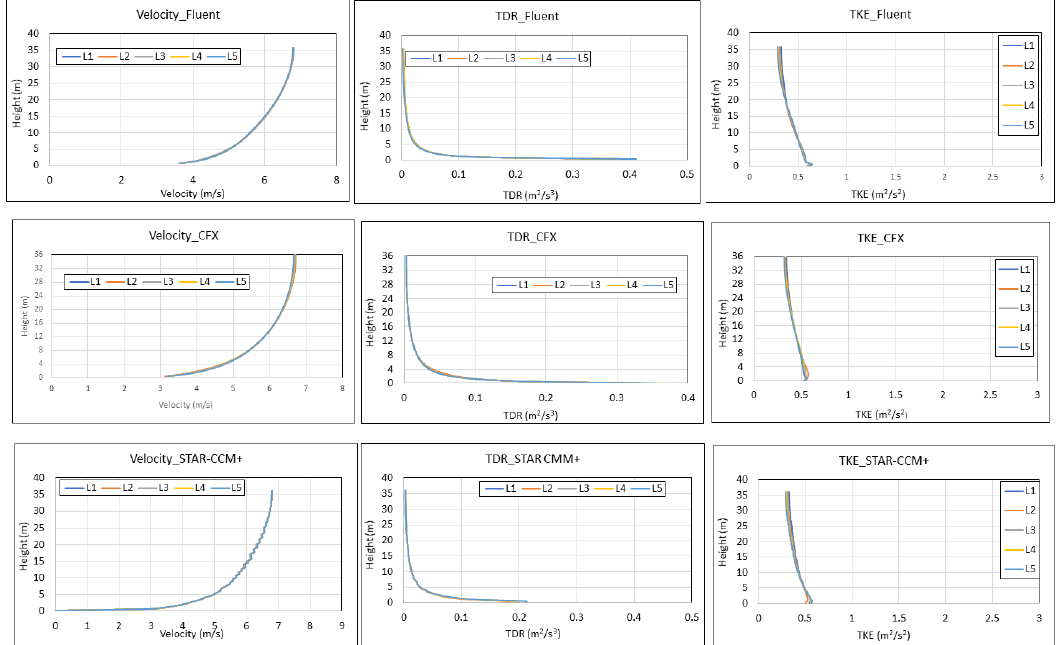
Figure 13. Case 3: Comparison of the vertical profiles at the 5 different locations for the streamwise velocity u , turbulent kinetic energy (TKE), and turbulent dissipation rate (TDR) using the three software.